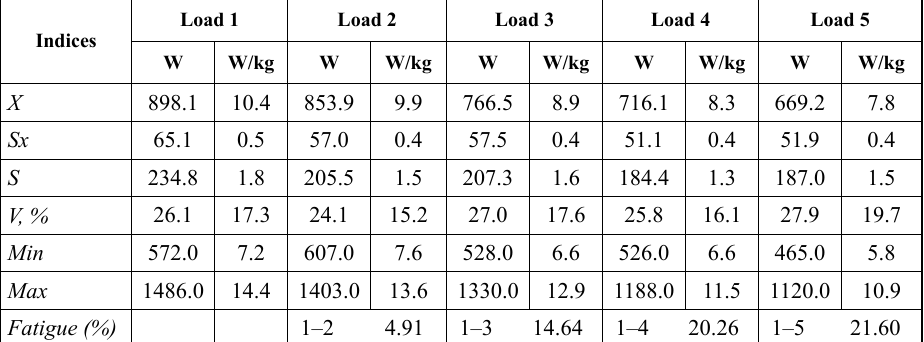
Table 3. Lithuanian deaf basketball national team members’ anaerobic alactic muscle power in performing repeated 5 x 6 s load and index of